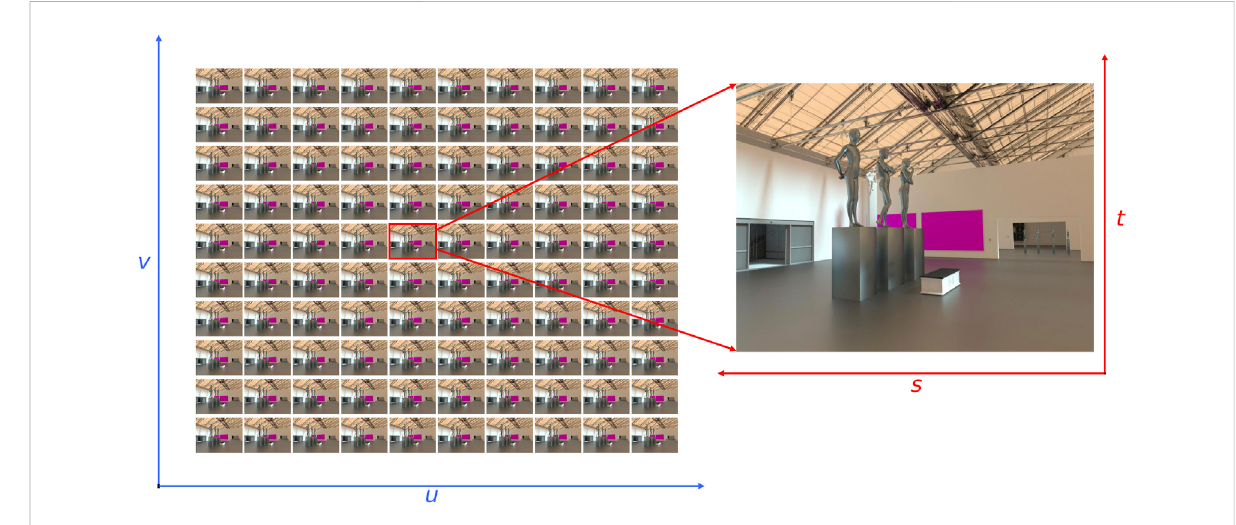
FIGURE 1 A grid of 10 × 10 sub-aperture images of a Light Field image (ArtGallery3) from MPI dataset (Adhikarla et al.,